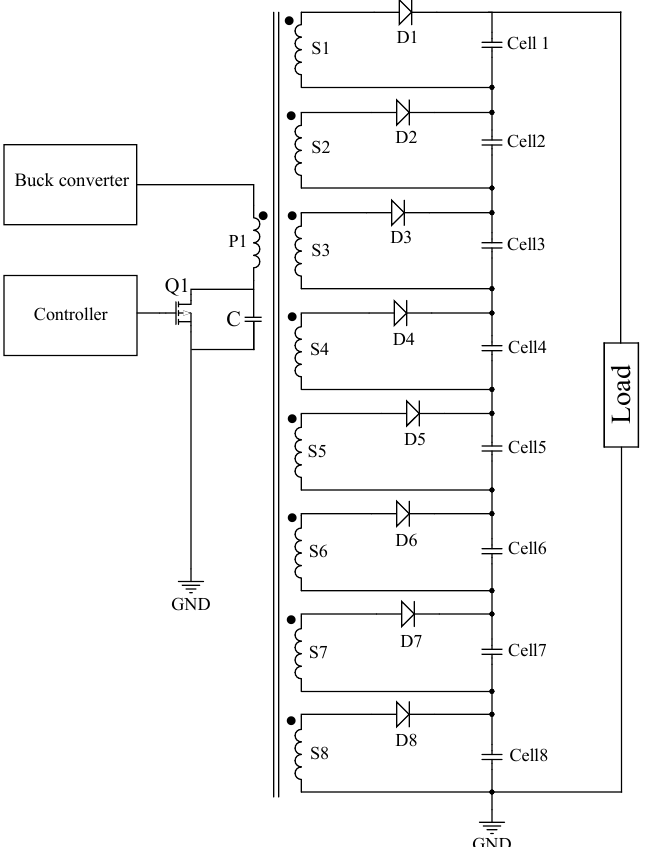
Figure 4. Schematic of the proposed forward converter balancing circuit for eight lithium-based battery